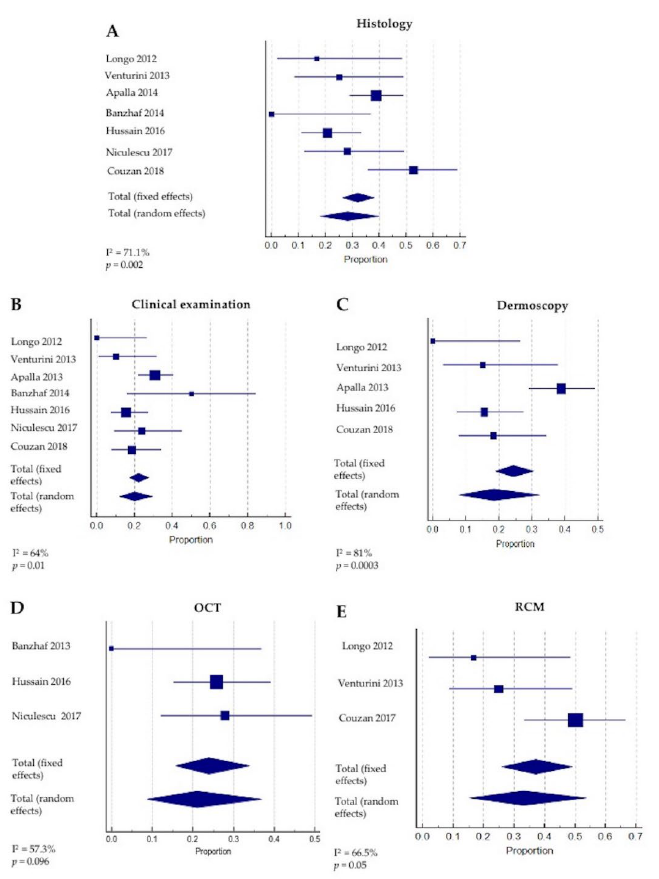
Figure 3. Proportion of included studies and rates of persistent tumors with ( A ) histology, ( B ) clinical examination, ( C ) dermoscopy, ( D ) optical coherence tomography, (OCT) and ( E ) reflectance confocal microscopy (RCM)